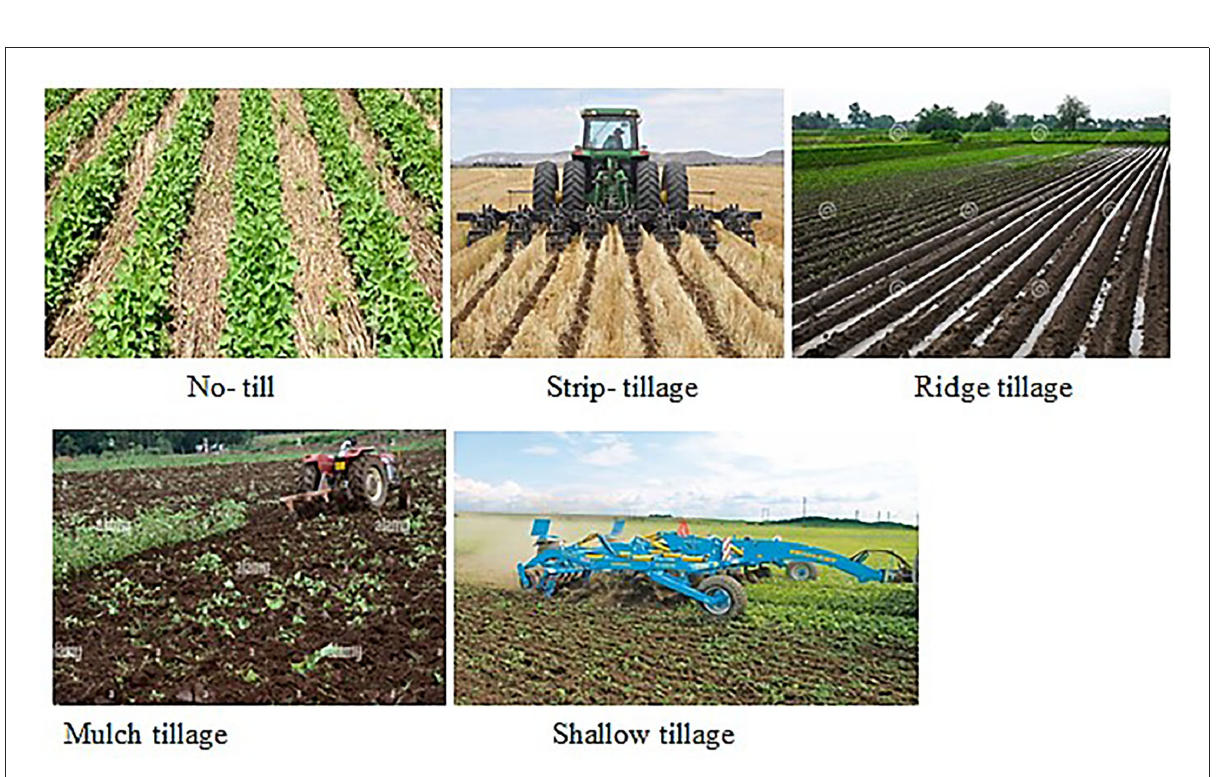
FIGURE7 Images of reduced tillage practices. Source: google